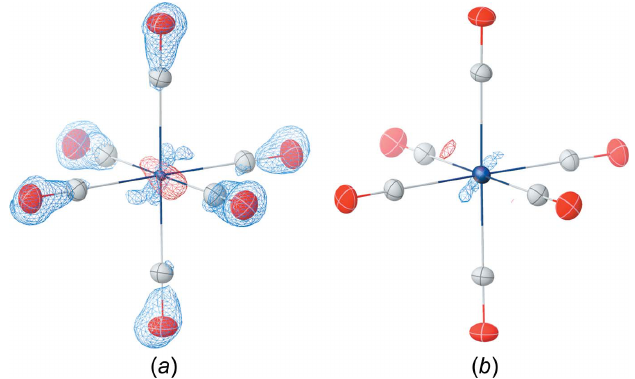
Figure 3 Negative (blue) and positive (red) residual electron density at an isosurface level of 0.33 e A˚ (cid:2) 3 of Mo(CO) 6 at 20 001 eV for the HAR model using ( a ) the Sasaki tabulated and ( b ) refined dispersion